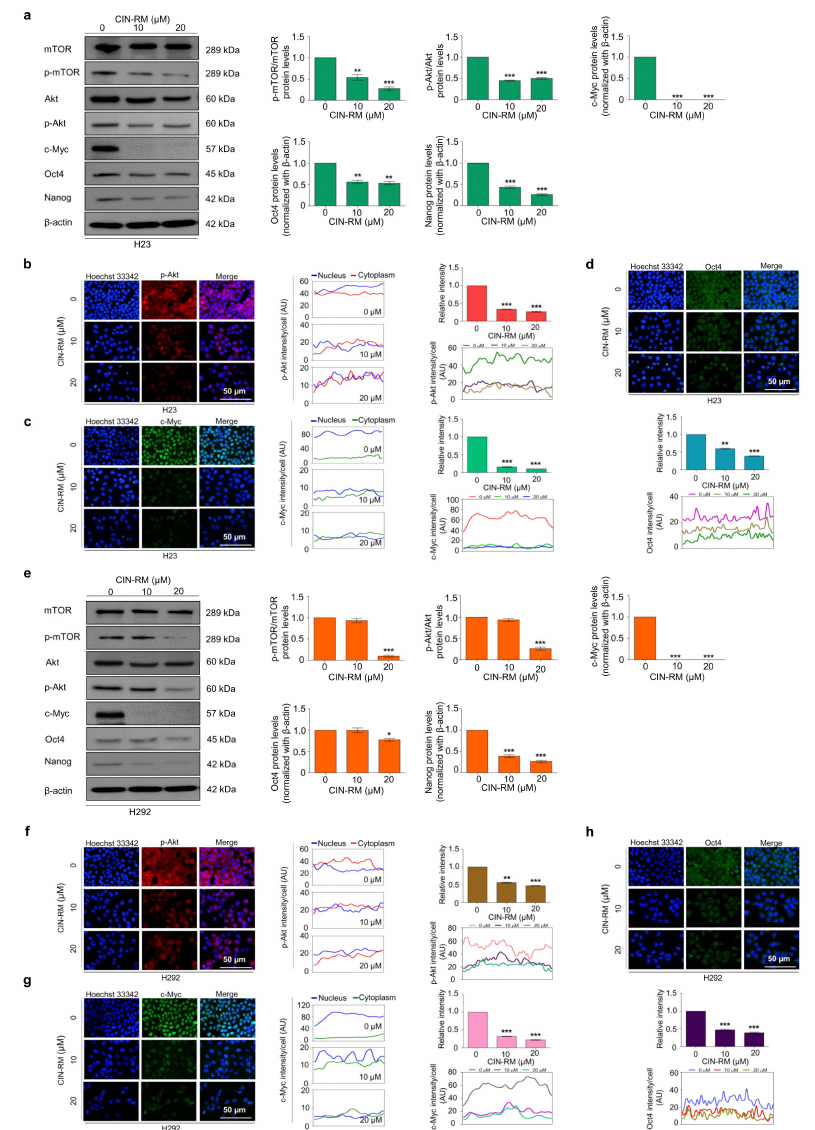
Figure 6. Effect of CIN-RM on lung cancer H23 ( a – d ) and H292 ( e – h ) cells. ( a ) H23 and ( e ) H292 cells were treated with various concentrations (0, 10, and 20 µ M) of CIN-RM for 24 h and the expression levels of mTOR, p-mTOR, Akt, p-Akt, c-Myc, Oct4, and Nanog proteins were investigated by Western blotting. Blots were reprobed with β -actin to confirm equal loading of samples. The immunoblot signals were quantified by densitometry. ( b , c , d ) H23 cells were treated with CIN-RN at toxic concentrations (0, 10, and 20 µ M) for 12 h. The cellular levels of p-Akt, c-Myc, and Oct4 were determined by immunofluorescence analysis. The fluorescence intensity of the nucleus and cytoplasm were analyzed by ImageJ software. ( f , g , h ) H292 cells were treated with CIN-RN at toxic concentrations (0, 10, and 20 µ M) for 12 h. The cellular levels of p-Akt, c-Myc, and Oct4 were determined by immunofluorescence analysis. The fluorescence intensity of the nucleus and cytoplasm were analyzed by ImageJ software. Values are presented as means ± SEM ( n = 3). * p < 0.05, ** p < 0.01, and *** p < 0.001 compared with untreated